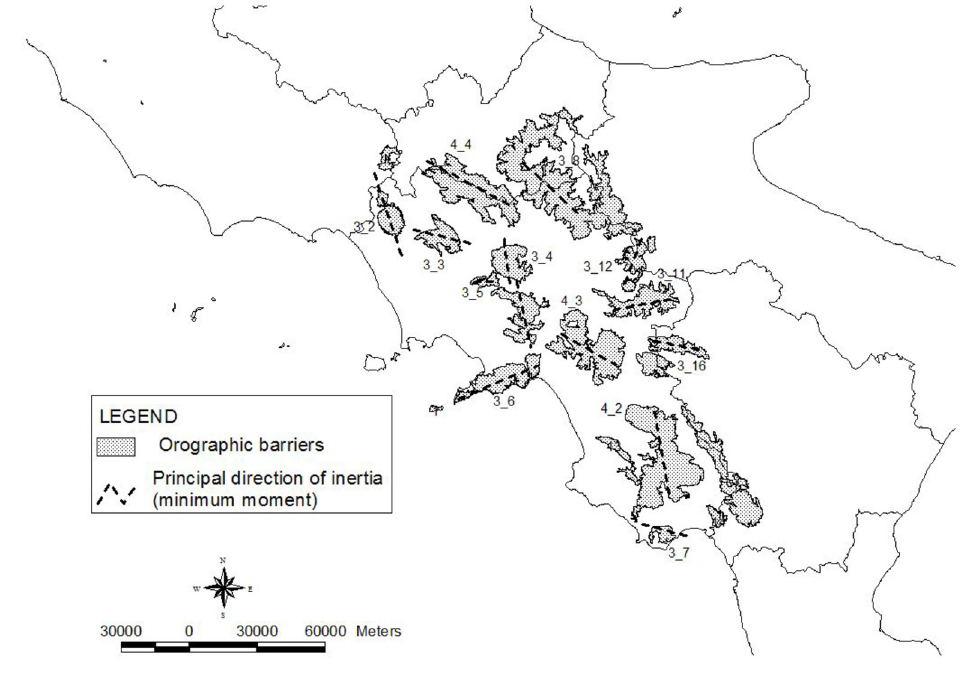
Figure 6. Principal directions of inertia related to the minimum moment of the orographic